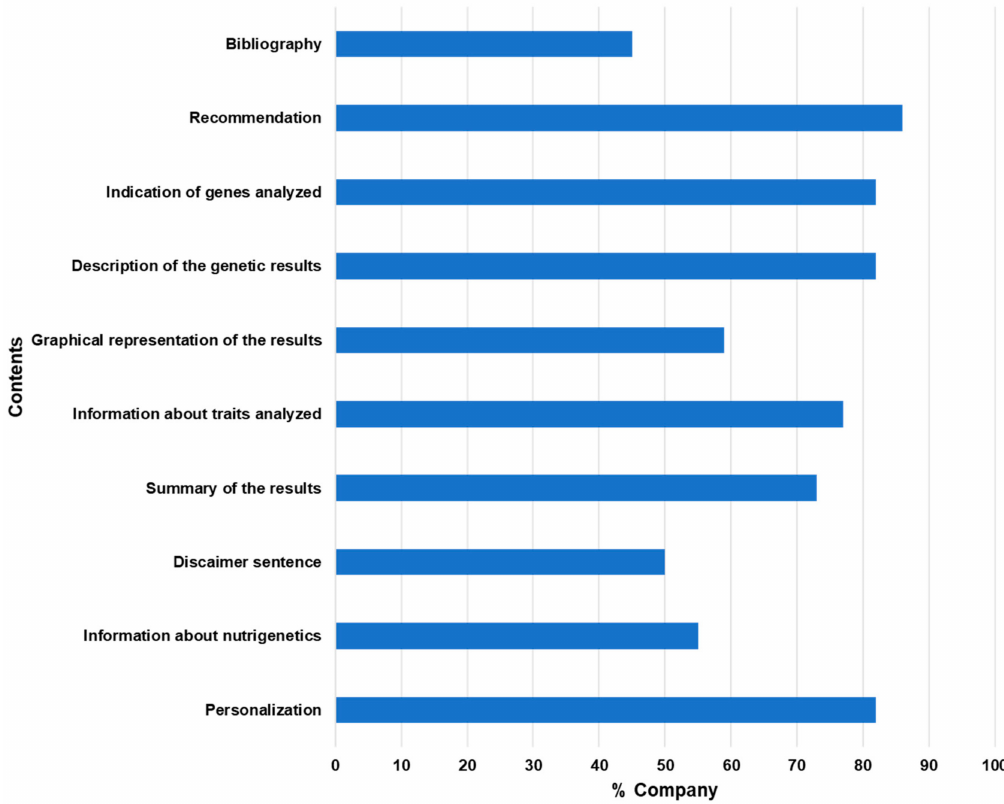
Figure 3. Analysis of the contents of the report examples provided by the selected DTC-GT companies. In the graph, the percentages of companies including specific contents in their report examples are represented in the